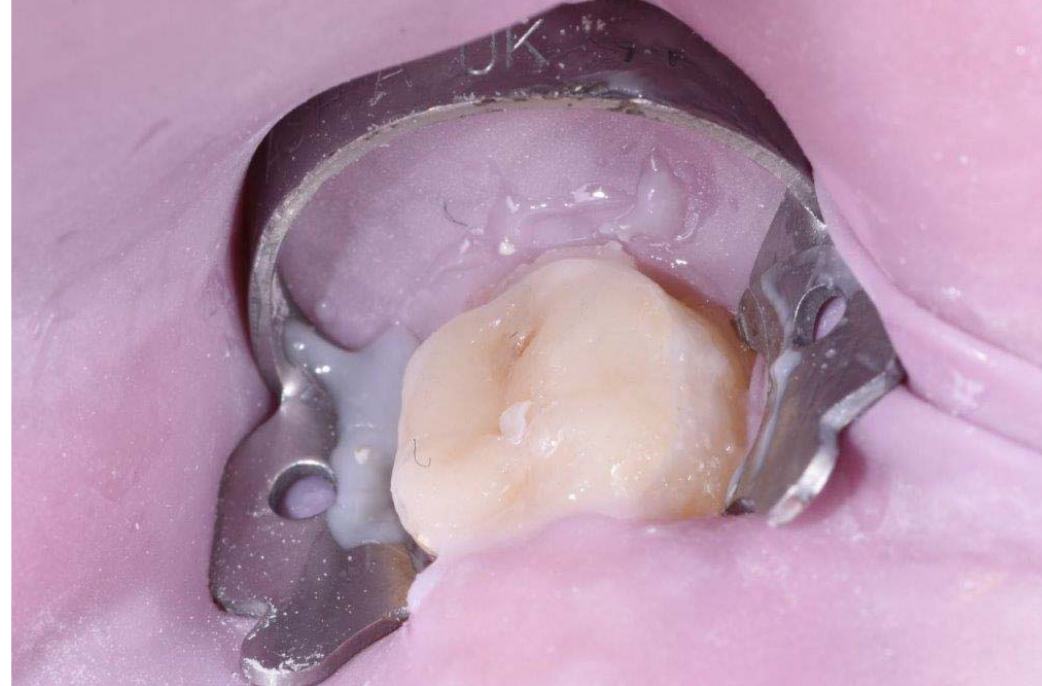
Figure 5. Cementation of restoration.